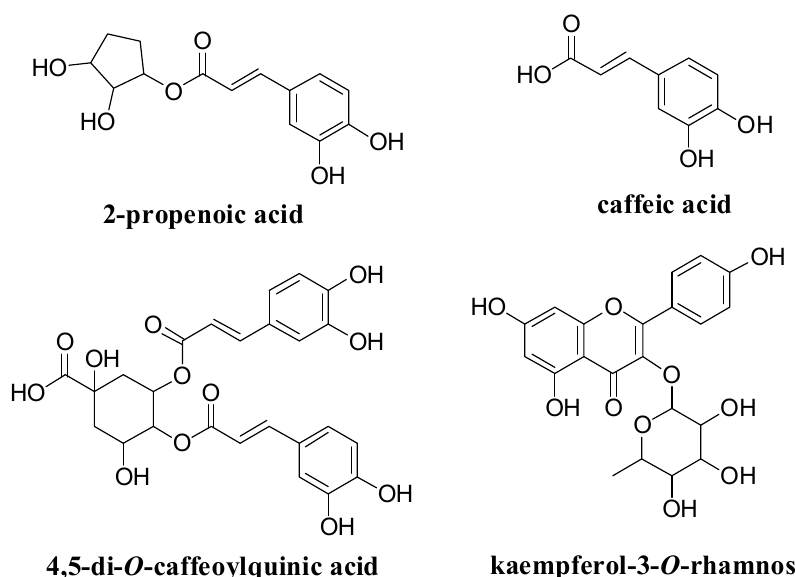
Figure 1. Structural identification of compounds isolated from Gynura divaricata ( L .) DC (GD) using HPLC.